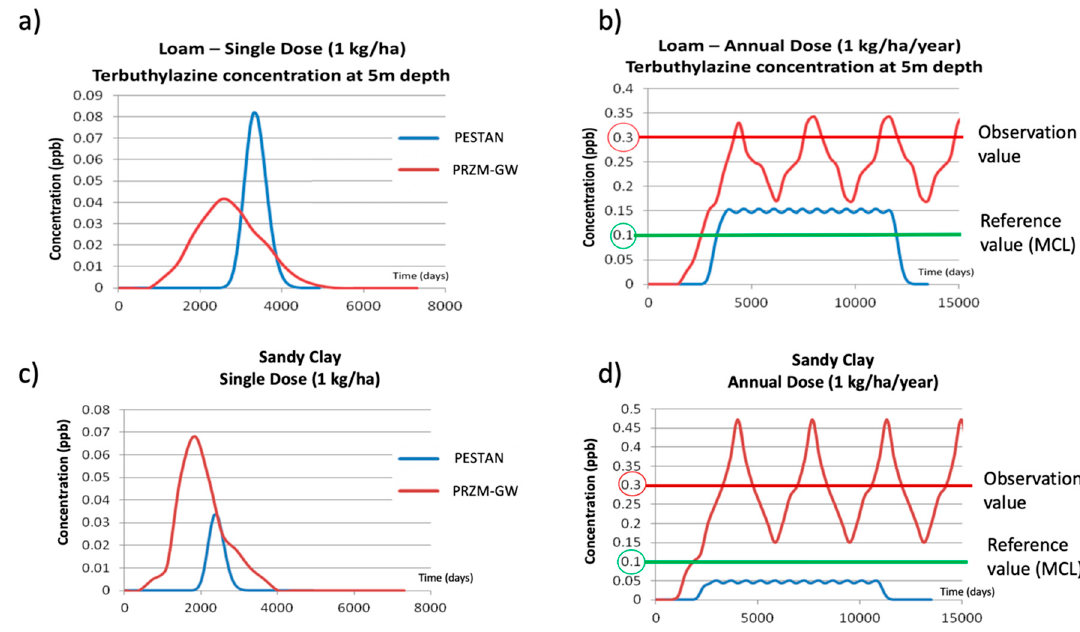
Figure 8. Simulation results for di ff erent soils. ( a ) Loamy soil. Single dose. ( b ) Loamy soil. Annual application ( c ) Sandy-clay soil. Single dose. ( d ) Sandy-clay soil. Annual application.